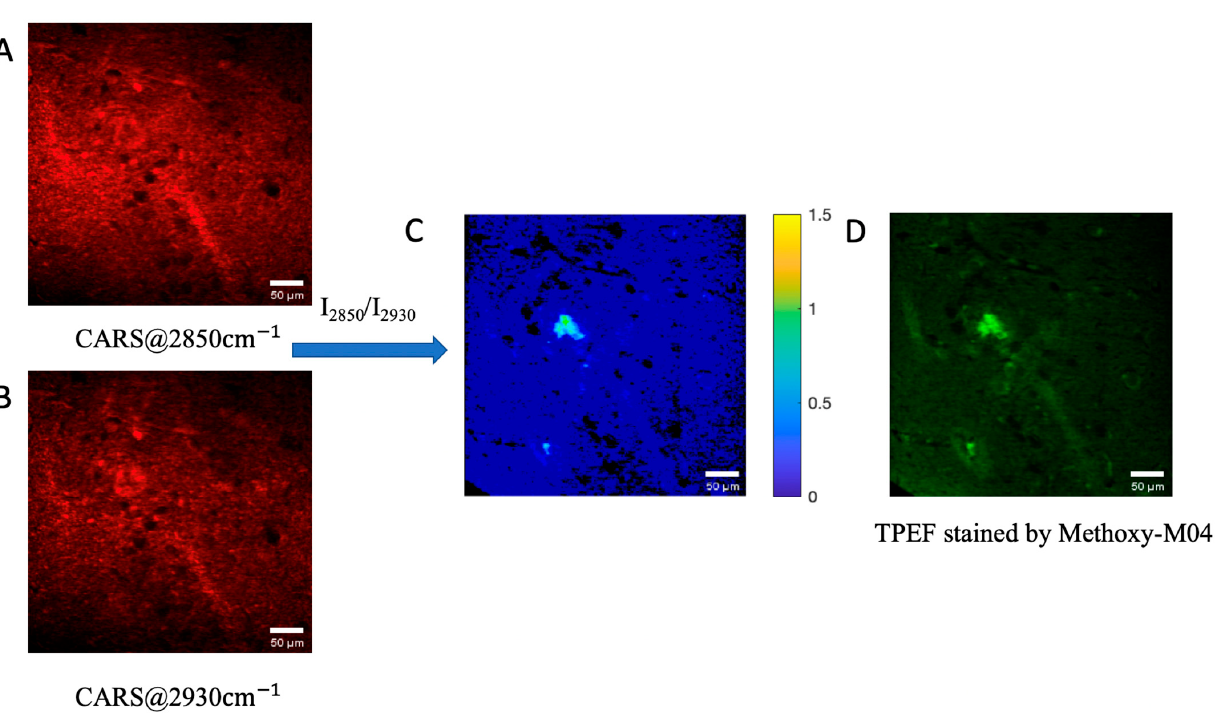
Figure 5. Workflow that can be used to verify the feasibility of distinguishing non-A β region from A β region in the AD brain tissue without labeling. Individual CARS images are shown: ( A ) 2850 cm − 1 ; ( B ) 2930 cm − 1 ; ( C ) the result of the image in A divided by the image in B, pseudo color in ( C ) stands for the peak ratio of each pixel. We can find an unusual area in the middle which could be regarded as the A β region; ( D ) the TPEF image stained by Methoxy-X04, which is used to locate the A β plaques and the A β region.